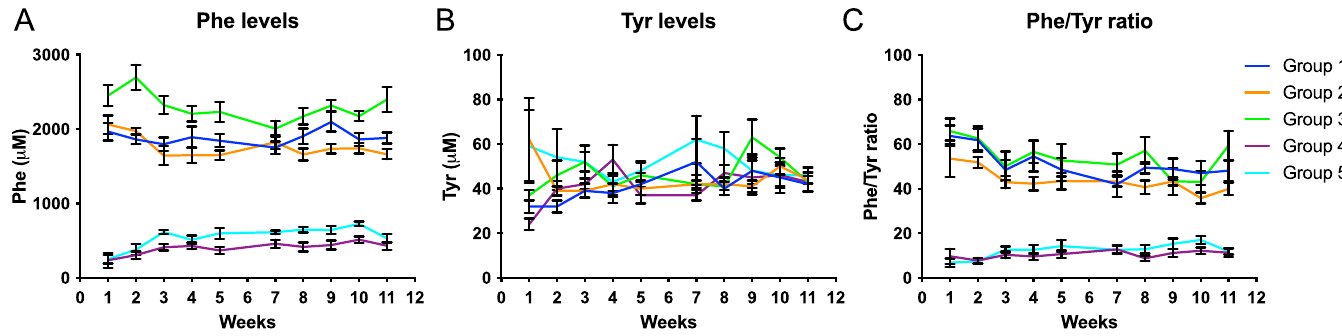
Fig 3. Average plasma Phe, plasma Tyr- and plasma Phe/Tyr-ratio ( μ mol/l), mean ± SD. G1-5/w1-11. A: Phe levels. G3 > G4 and G5 at all time points (p < 0.01), G3 > G1 at w2 (p < 0.05), G5 > G4 at all time points except w2, 4 and 11 (p < 0.05). B: Tyr levels. G1 (0.0126 ± 0.0009), G2 (0.0133 ± 0.0019), G3 (0.0116 ± 0.0023), G4 (0.0152 ± 0.0021) and G5 (0.0160 ± 0.0009). W1: G3 > G4, w7: G5 > G4, w9: G3 > G2 (p < 0.01). C: Phe/Tyr levels. G1 (0.0463 ± 0.0016), G2 (0.0481 ± 0.0021), G3 (0.0452 ± 0.0026), G4 (0.0503 ± 0.0029) and G5 (0.0511 ± 0.0024),(G2 > G3 (p < 0.05), G4 > G3 (p = 0.001), G5 > G3 (p < 0.001). Group 1–5 represent: G1(N-CGMP), G2 (N-CGMP-LNAA), G3 (N), G4 (CGMP-EAA-LP) and G5